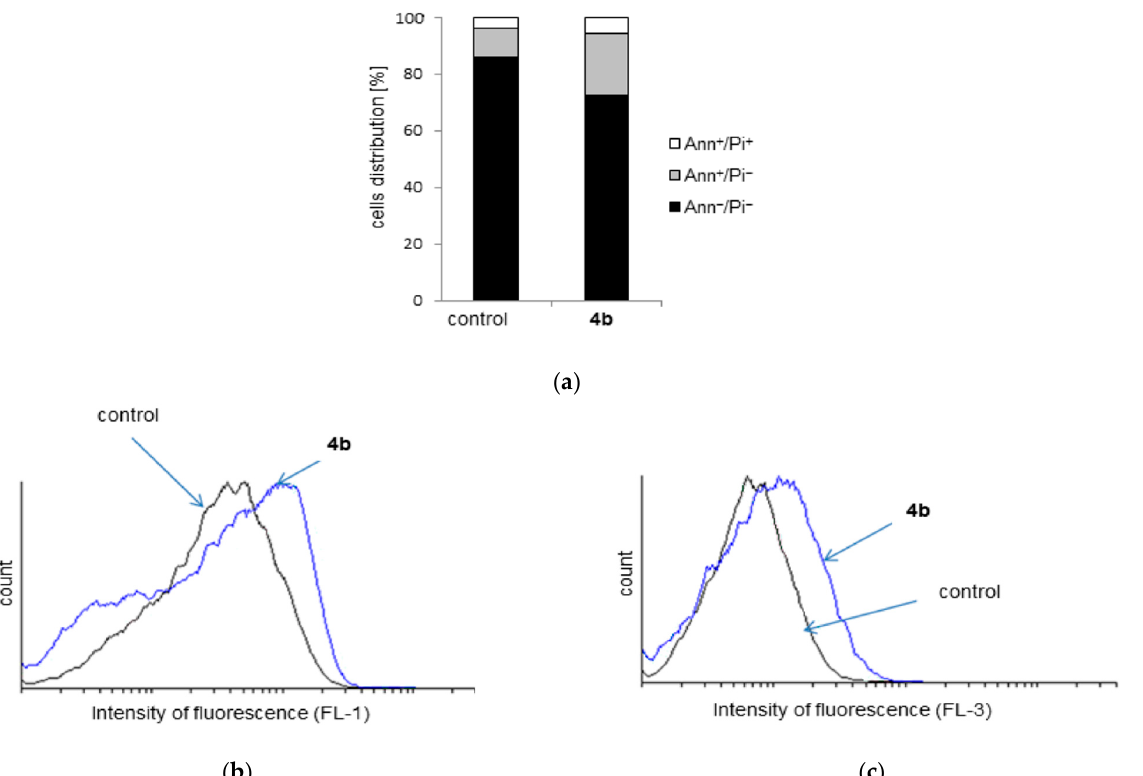
Figure 6. 8505C cells treated with 4b : ( a ) apoptosis, ( b ) caspase activation, and ( c ) induction of autophagy after 72 h of treatment with IC 50 dose.